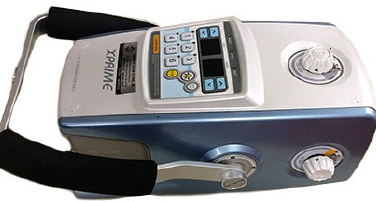
Figure 3. The PXP-16HF XPRIME Portable Radiograph Machine used to obtain radiographs. Lateral Radiograph (Lateromedial)